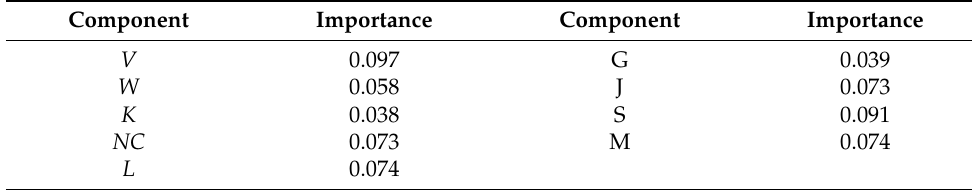
Table 10. Importance of each component of machining